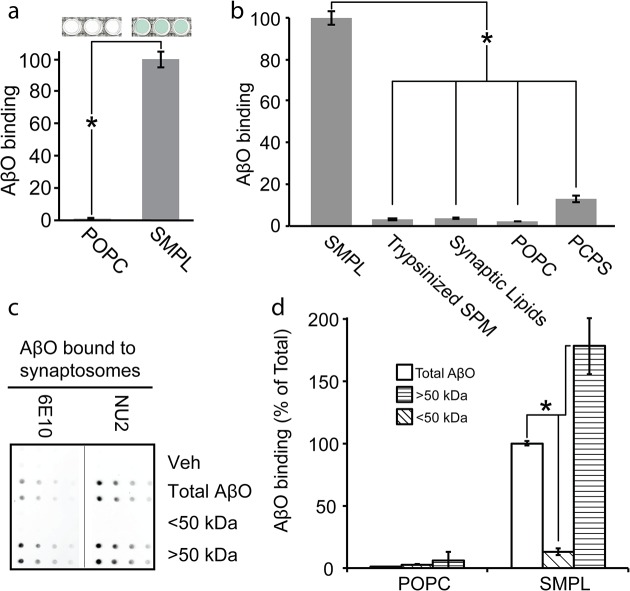
Synaptic Nanodiscs contain an AβO binding protein that interacts selectively with high molecular weight oligomers.A Nanodisc-based assay for AβO binding indicates the transfer of the AβO binding site into Nanodiscs (a) (n = 3; mean +/- SD; * p<0.05). Nanodiscs containing a range of detergent-solubilized precursor membranes or lipid mixtures were applied to the AβO binding assay (b; SPM—synaptic plasma membrane, Trypsinized SPM—SPM treated with trypsin prior to Nanodisc incorporation, Synaptic Lipids—lipids extracted from SPM, POPC—100% POPC lipid, PC/PS—1:1 POPC:POPS; n = 3; mean +/- SD; * p<0.05). AβOs were separated into populations smaller (diagonal fill) and larger (horizontal fill) than 50 kDa and assayed for binding to synaptosomes (c) and Nanodiscs (d). (n = 2; mean +/- SD; * p<0.05)